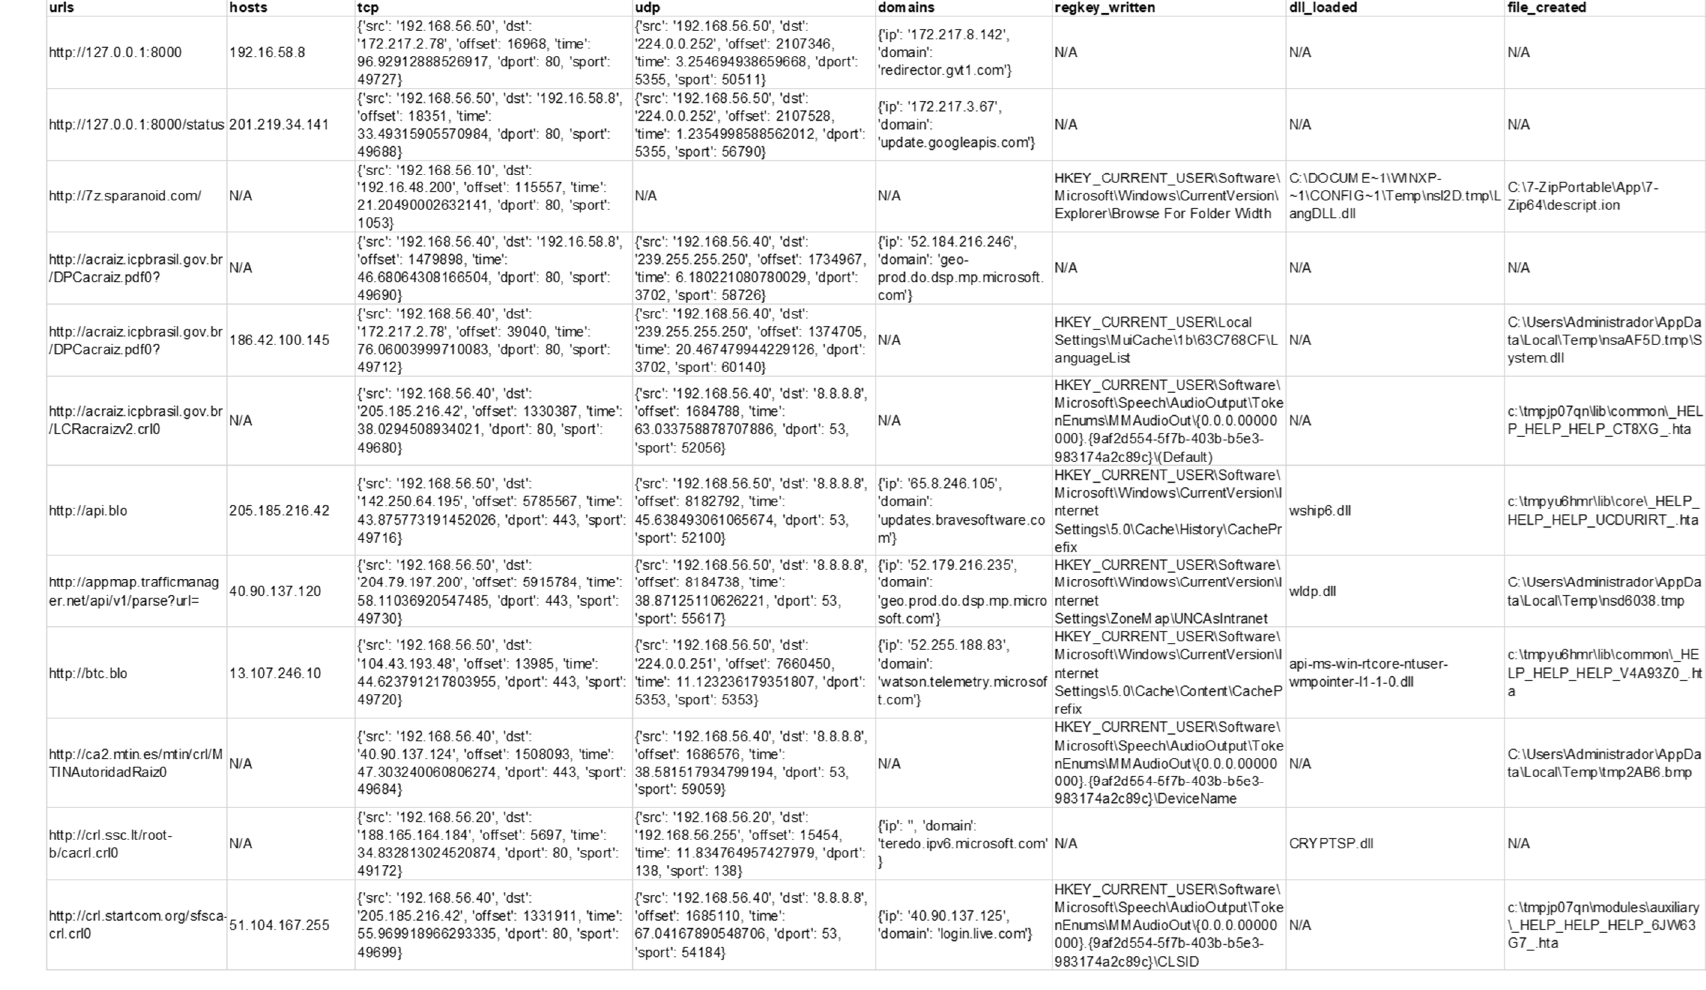
Figure 7. Information of some features for a single artifact—Dataset obtained in step 1